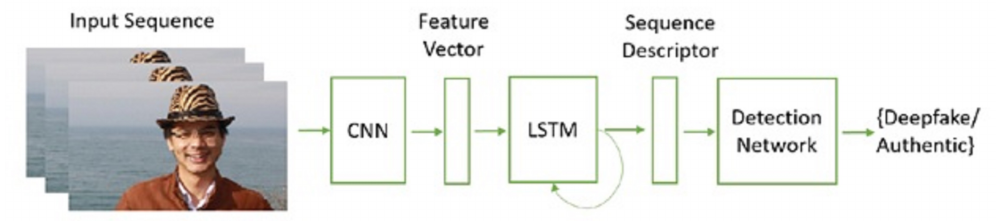
Figure 8. Deepfake detection using CNN and LSTM